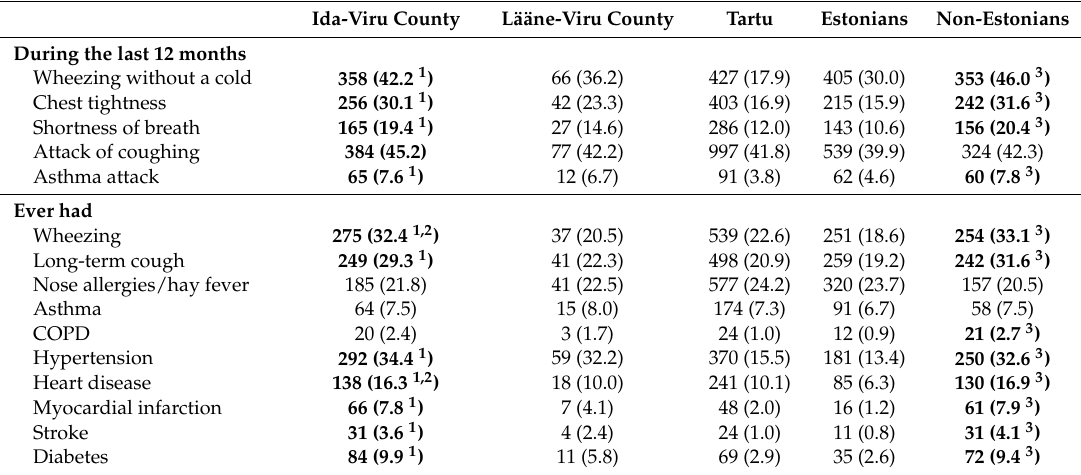
Table 2. The prevalence of respiratory and cardiovascular diseases in different counties and among ethnic groups, n